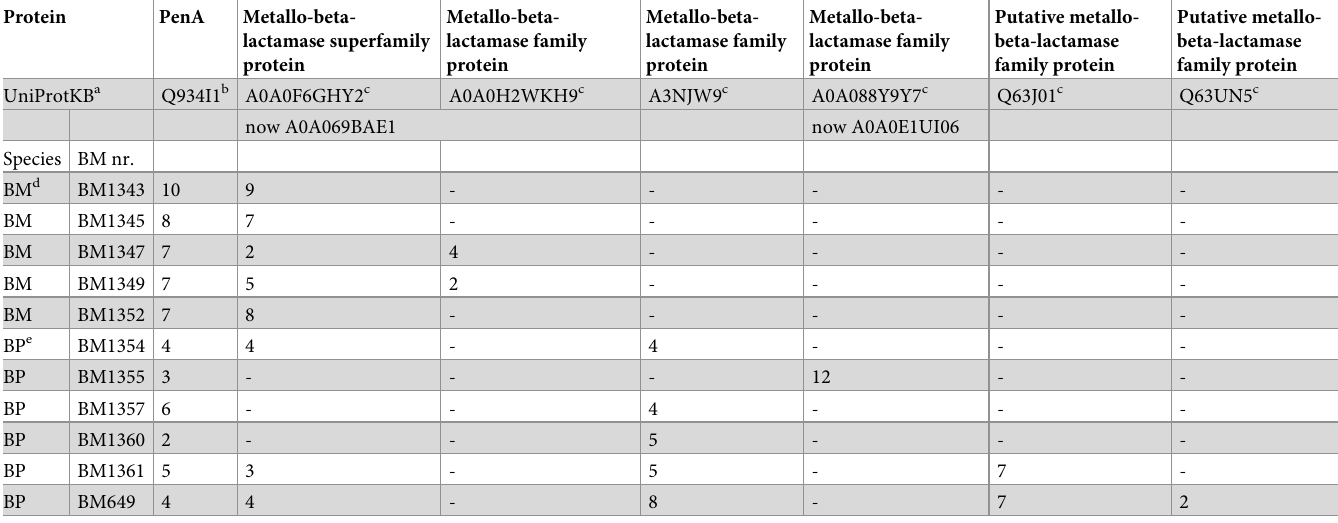
Table 7. Number of detected peptides from (potential) β lactamases or carbapenemases. Protein